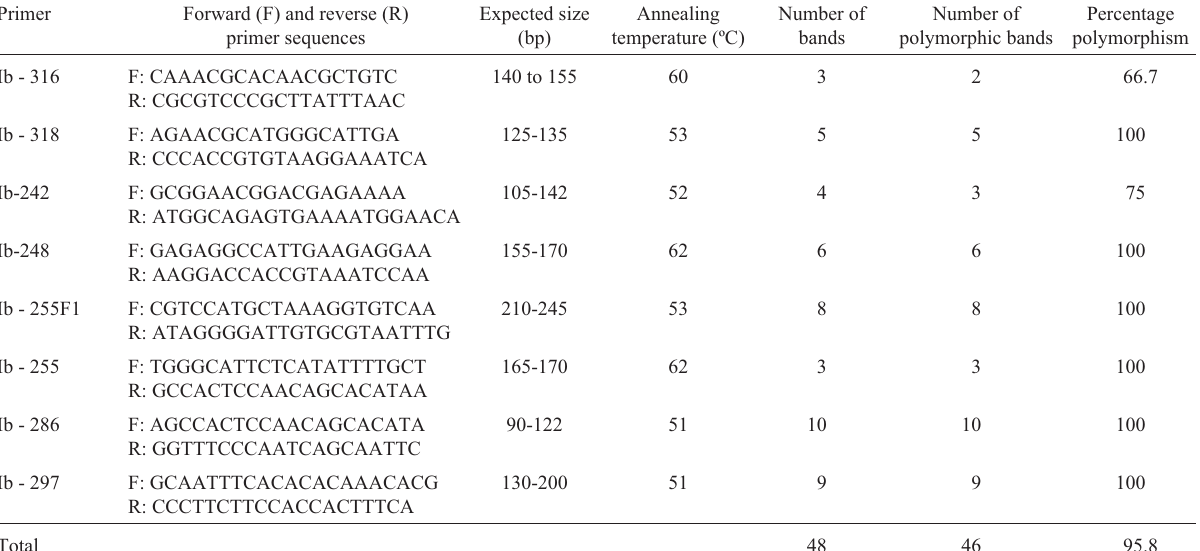
Table2 -Optimizedpolymerasechainreactionconditionsforthemicrosatellitemarkersusedfortheanalysisof78sweetpotato( Ipomoeabatatas )acces- sions from the Vale do Ribeira, São Paulo, Brazil. Primer Forward (F) and reverse (R) primer